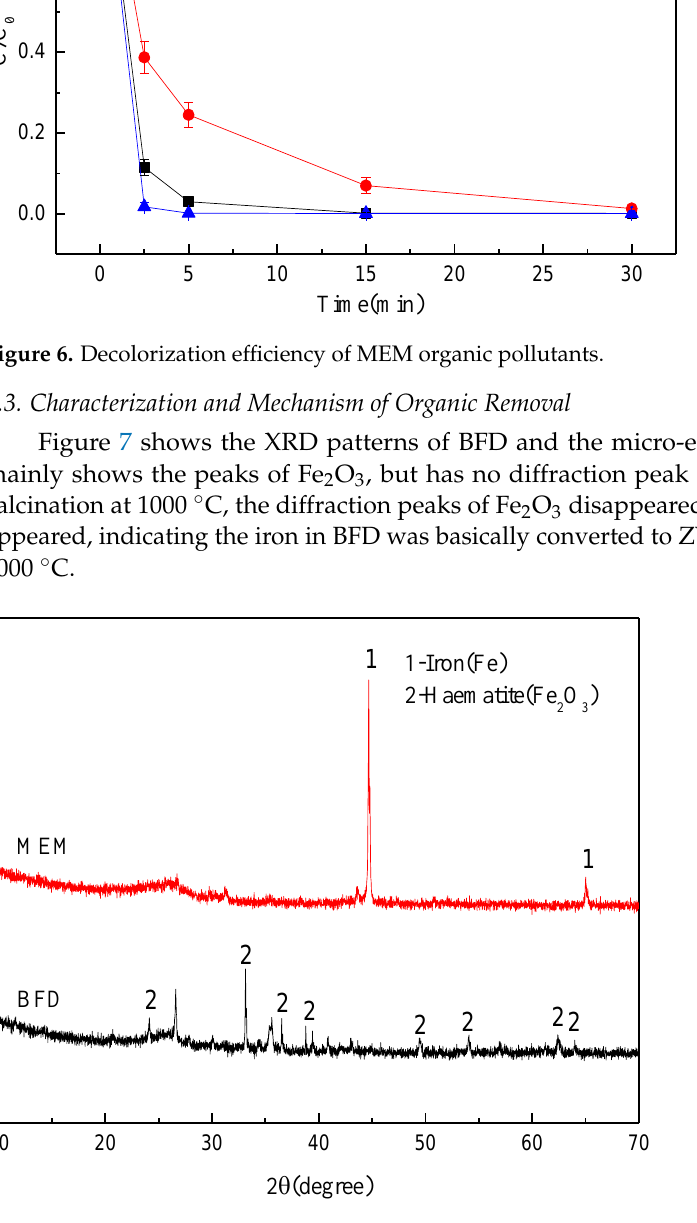
Figure 7. XRD patterns: BFD; Micro electrolytic composite material prepared at 1273.15 K.